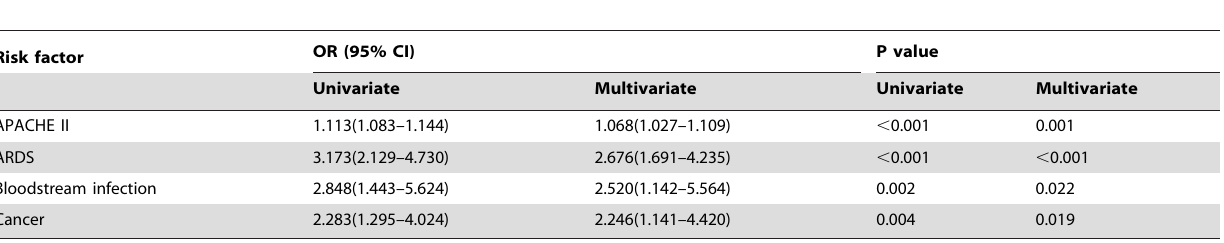
Table 5. Multivariate logistic regression analysis of independent predictors of hospital mortality in patients with severe sepsis and septic